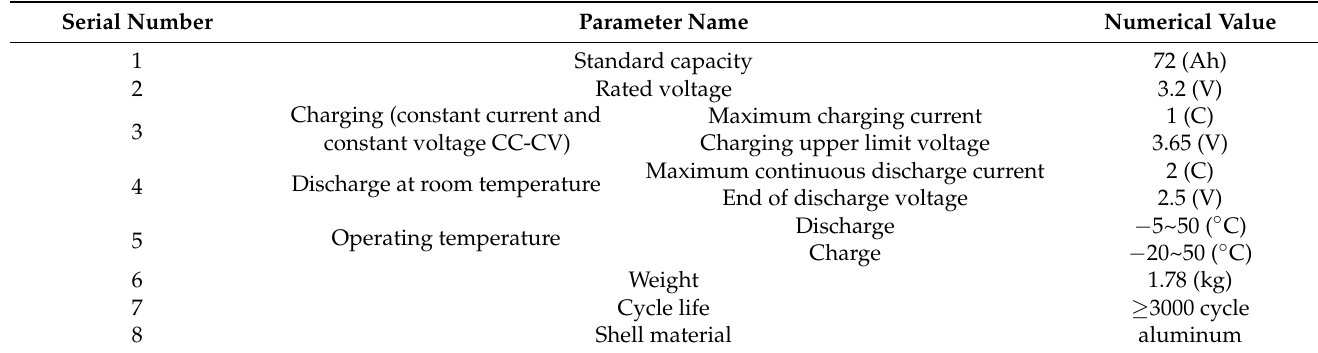
Table 1. Parameter table of lithium-ion